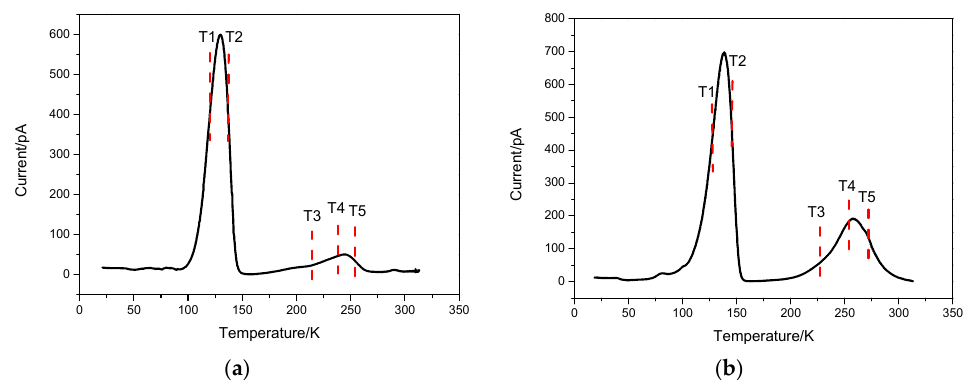
Figure 1. Results of TSC measurement ( a ) detector with better counting performance; ( b ) detector with poor counting performance.